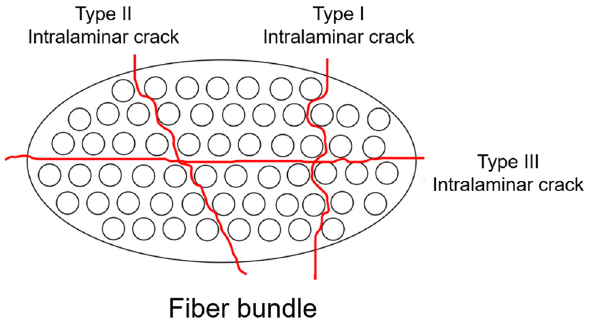
Figure 6: Schematic showing types of intralaminar